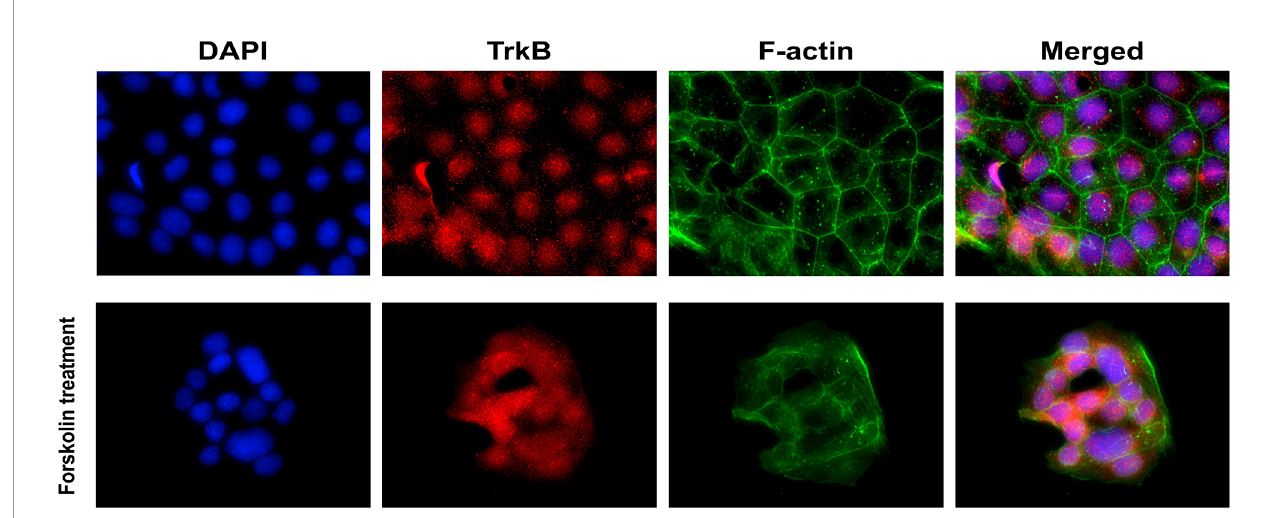
FIGURE 2 | Localization of BDNF receptors in placental BeWo cells. Representative immuno fl uorescent images showing DAPI, TrkB, and